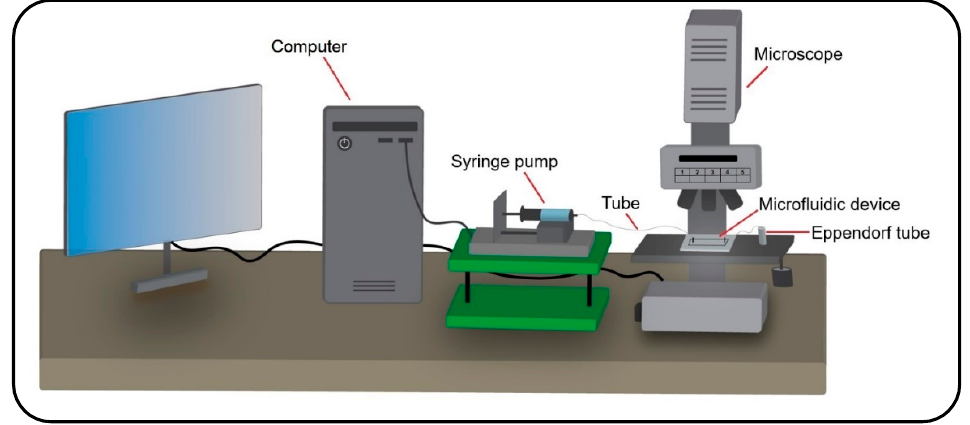
Figure 5. Schematic diagram of the experimental setup for injecting the particles into a microfluidic device using a syringe pump and monitoring their dynamics throughout the device with a micro-scope.